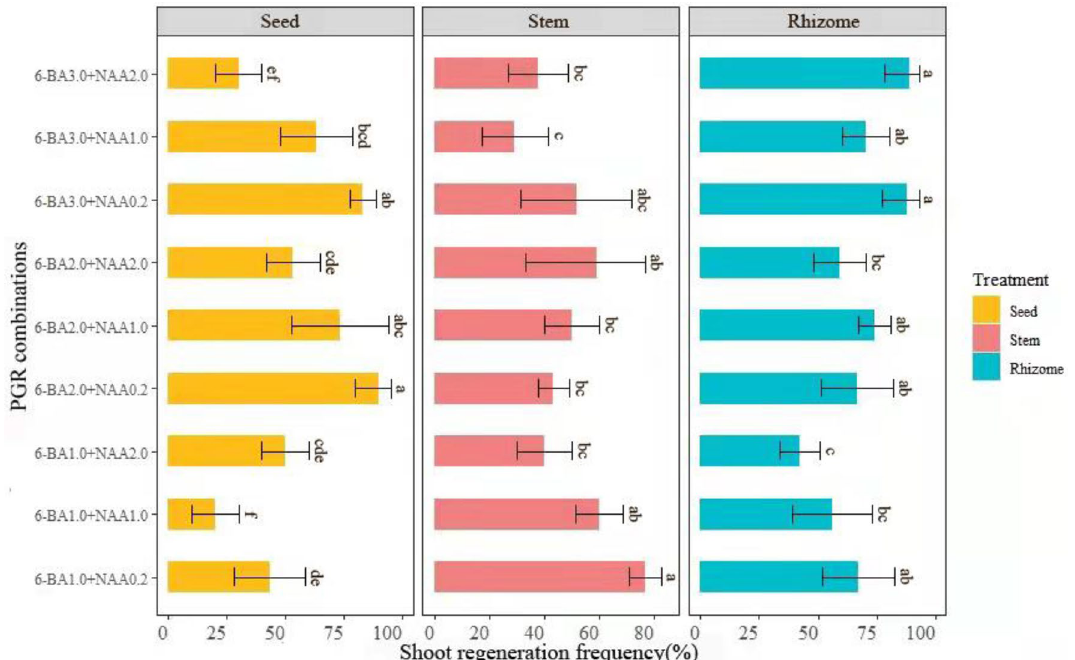
Figure 3. The effect of different concentrations of 6-BA and NAA on the adventitious shoot bud formation from seed, stem, and rhizome callus cultured on MS medium. Values with different letters indicate statistically significant differences ( P < 0.05) comparing the treatments (differences in combinations of callus bud differentiation hormones of similar origin). Note the log-scaled